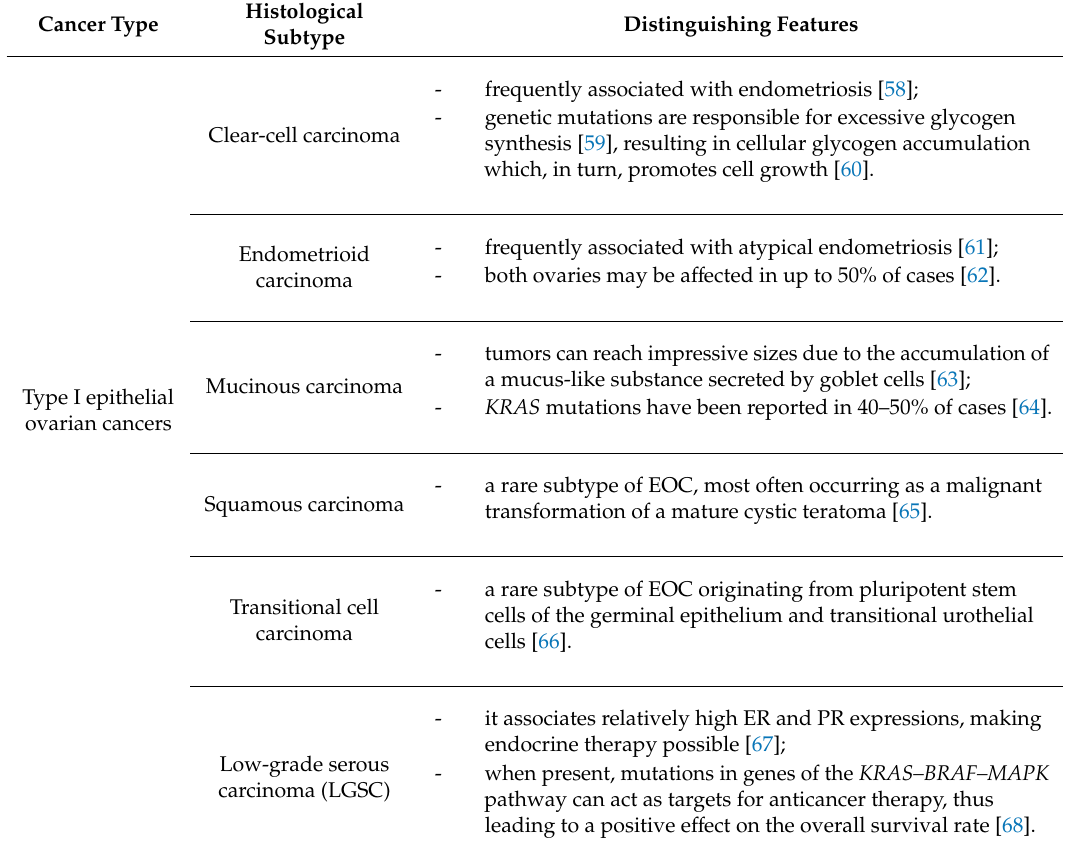
Table 1. Ovarian cancer